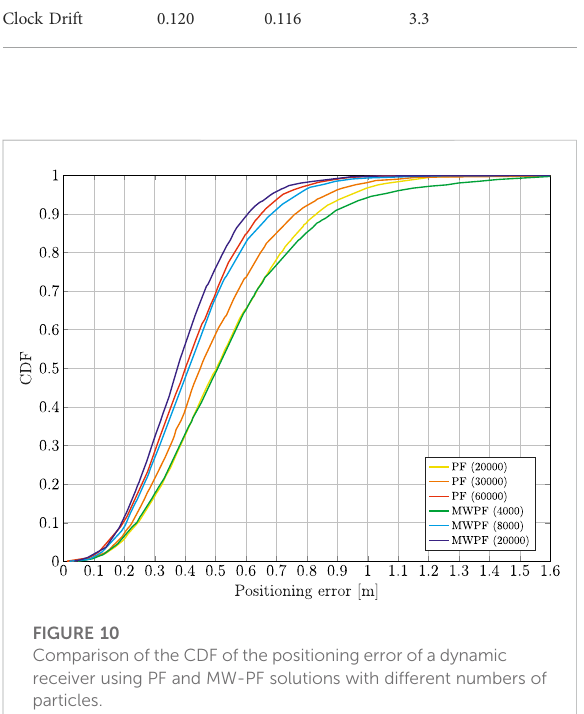
FIGURE 10 Comparison of the CDF of the positioning error of a dynamic receiver using PF and MW-PF solutions with different numbers of particles.